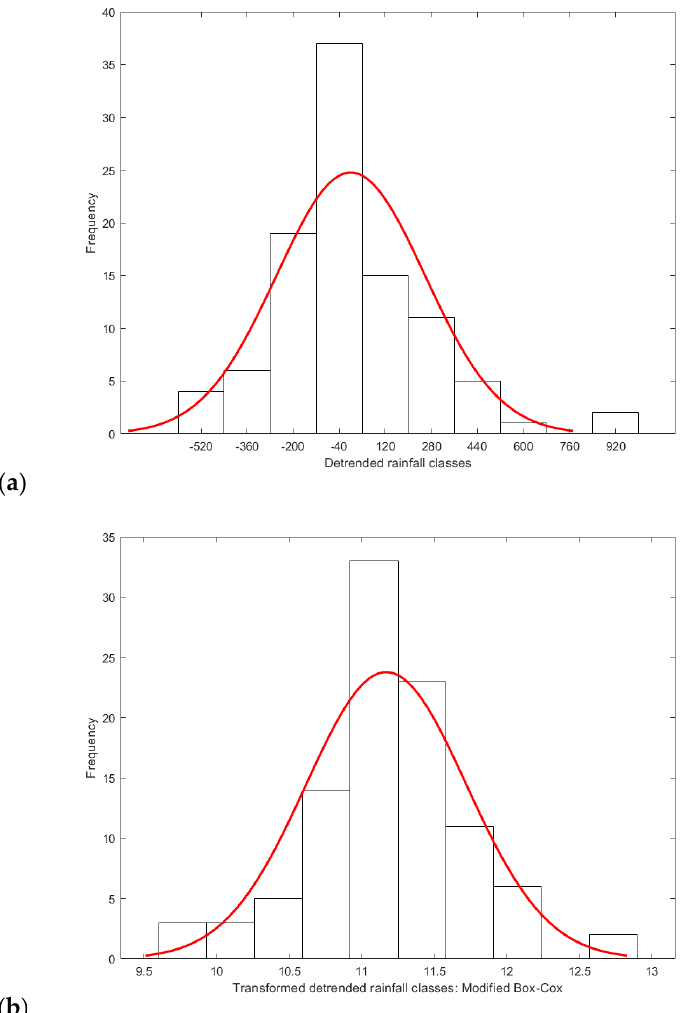
Figure 3. Histograms, which fitted the gaussian curve (red), of detrended rainfall data ( a ) and of transformed values ( b ) using the Modified Box-Cox method.